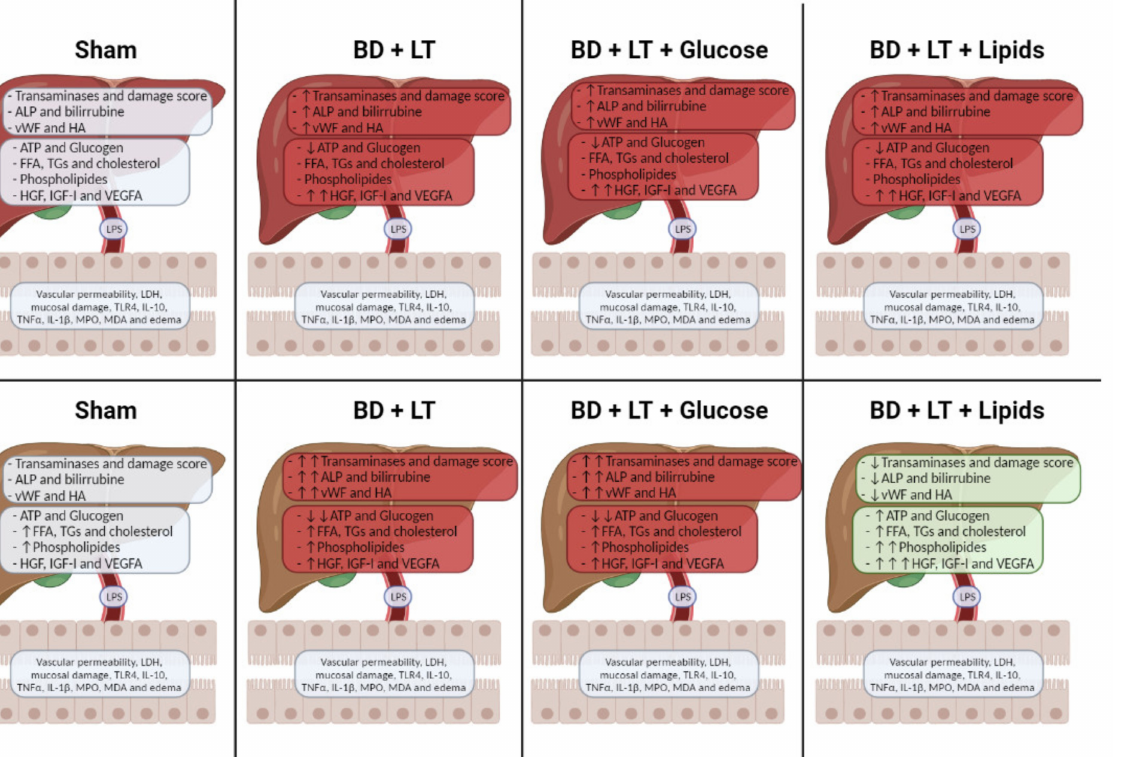
Figure 9. Schematic representation showing the effects of the different interventions on liver and intestine. Non-steatotic ( A ) and steatotic ( B )